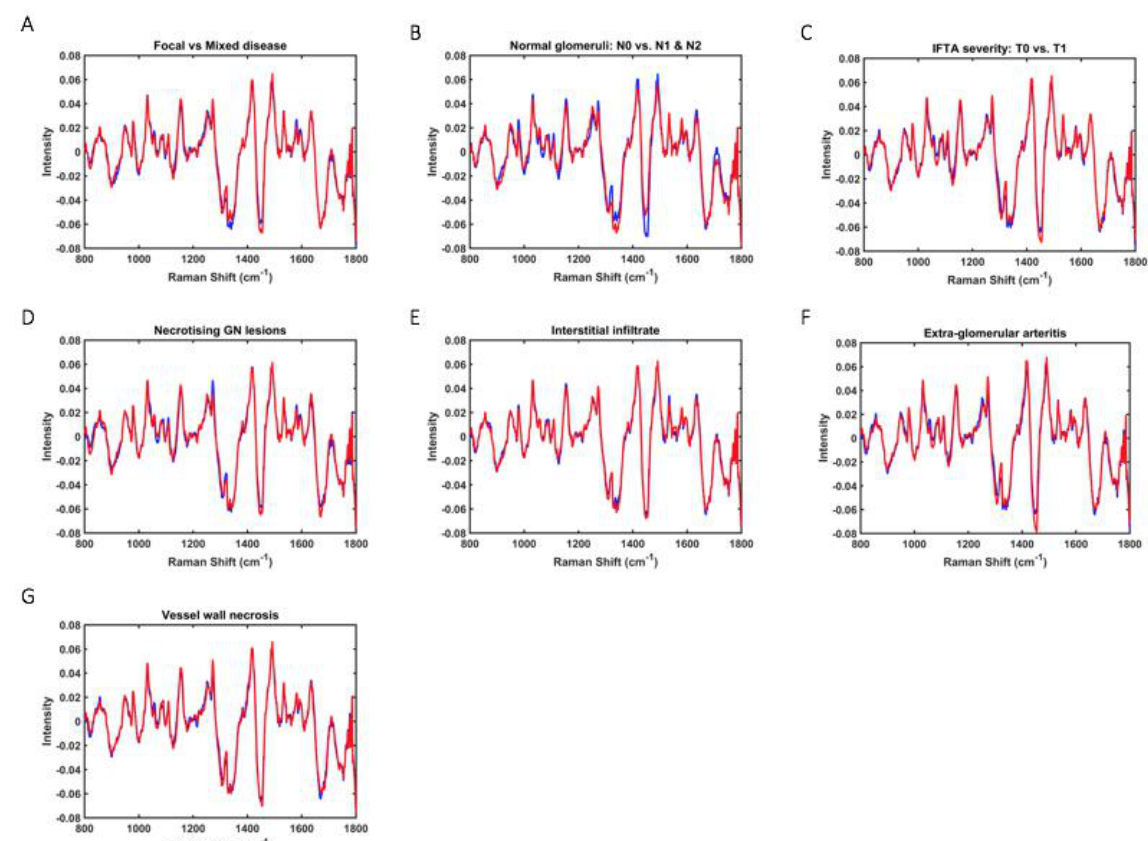
Figure 3. Mean Raman spectral data for each histological group— ( A ) focal vs. mixed disease, ( B ) proportional of normal glomeruli, ( C ) severity of interstitial fibrosis and tubular atrophy (IFTA), ( D ) presence of necrotising glomerular (GN) lesions, ( E ) presence of interstitial infiltrate, ( F ) presence of extra-glomerular arteritis, ( G ) presence of vessel wall necrosis.